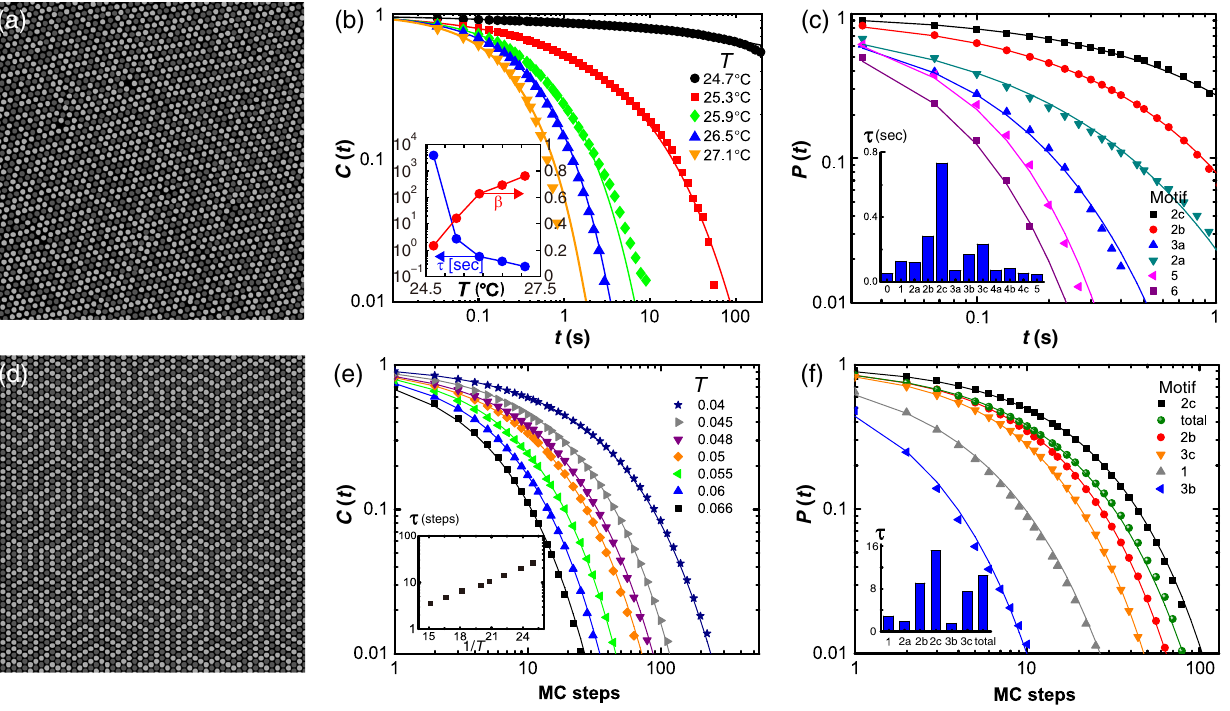
FIG. 3. The dynamics of the repulsive buckled crystal in (a) – (c) and the Coulomb liquid in (d) – (f). The simulation counterpart of (a) – (c) is Fig. S5 of SM [14]. (a),(d) Typical real-space structures. Coulomb charges (white spots) fill half of the triangular lattice. (b),(e) Spin or charge autocorrelation function C ð t Þ ensemble averaged over all motifs. Panel (b) is reproduced from Ref. [10] with permission, copyright 2008, Nature Publishing Group. (c),(f) Persistence function of each type of motif. This function describes the fraction of motifs that have not changed state during time t . Solid curves in (b),(c),(e),(f) are stretched exponential fits, exp ½ − ð t= τ Þ β (cid:3) , with the relaxation time τ shown in the insets. Temperature T ¼ 25 . 3 °C in (a),(c) and T ¼ 0 . 04 in